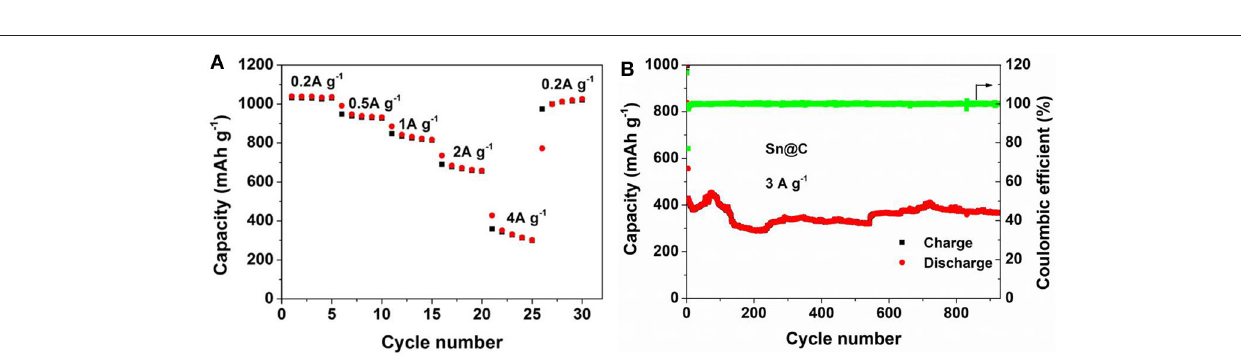
FIGURE 6 | (A) Rate capacity and (B) cycling performance of Sn@C at 3A g − 1 after 500 cycles at 0.8A g − 1